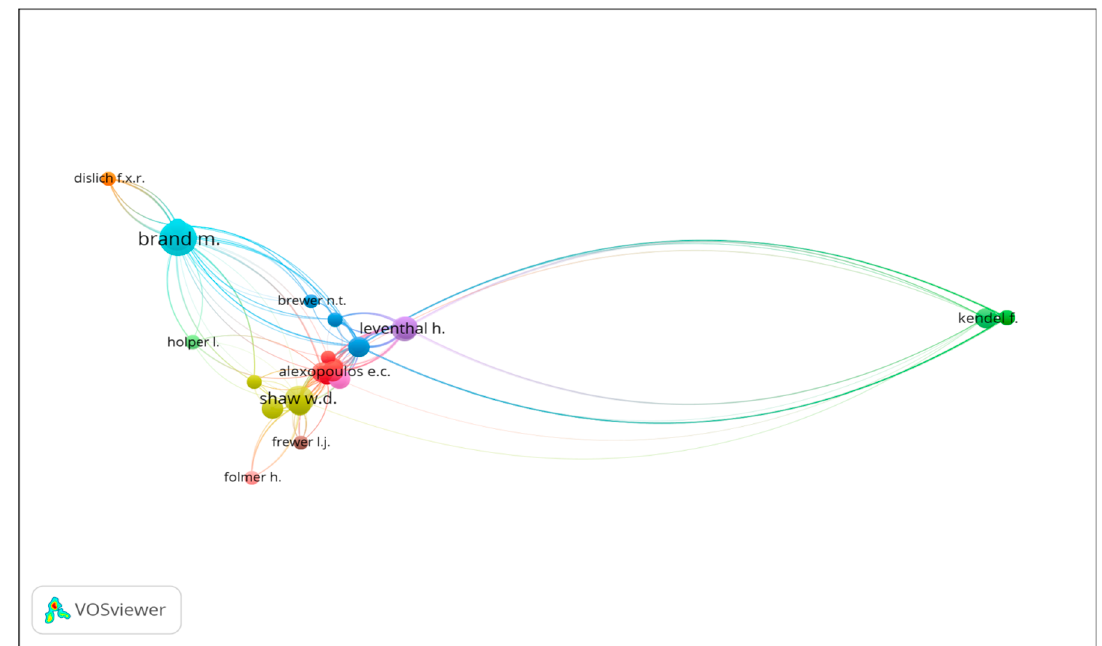
Figure 3. Visualisation map of Top 20 Authors of Related Documents.